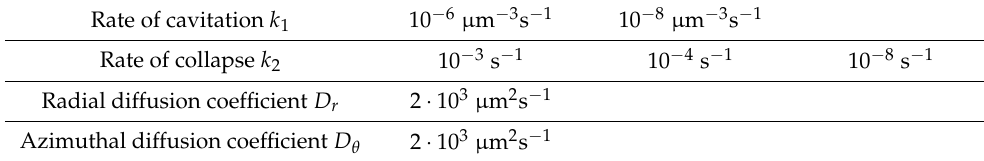
Table 2. Characteristic constants of the Table 1. Initial conditions and supply of bubbles.